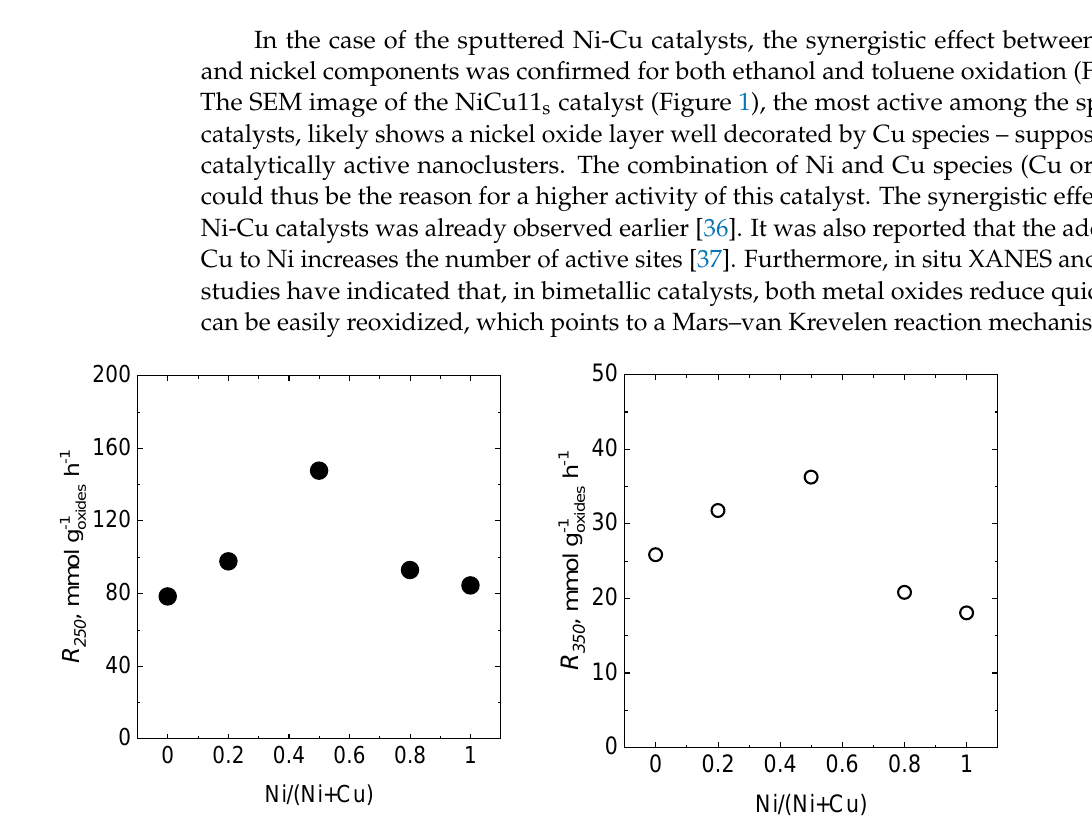
Figure 8. Catalytic activity of granular catalysts expressed as specific reaction rate R 130 in the oxida- tion of ethanol ( left ), and specific reaction rate R 270 in the oxidation of toluene ( right ) in dependence on Ni/(Ni + Cu) molar ratio.